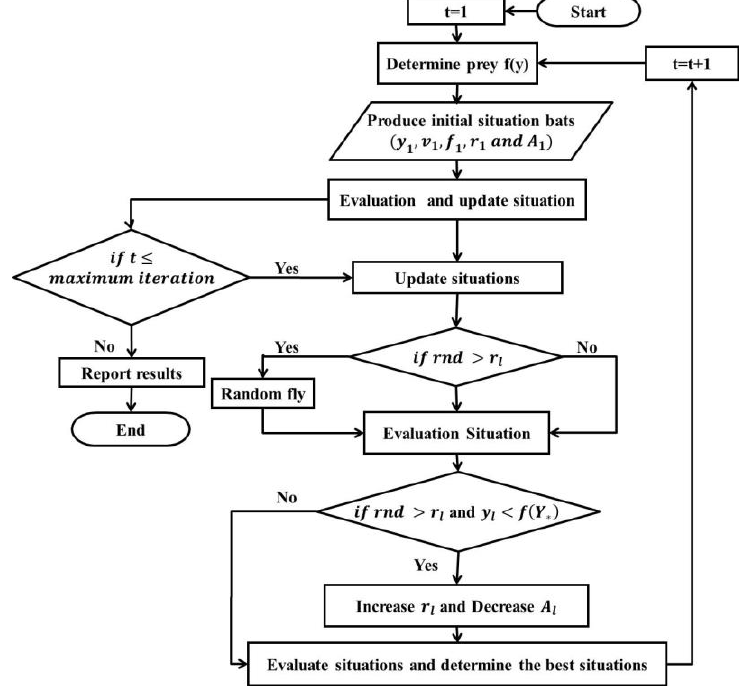
Figure 1. Bat Algorithm procedure.